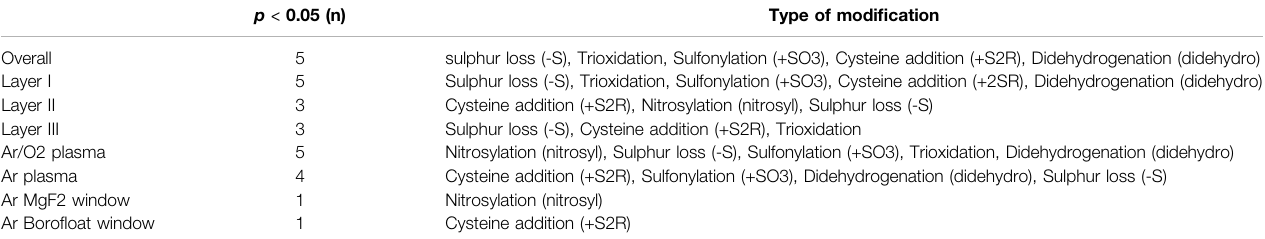
TABLE 3 | Cysteine focused protein modi fi cations observed in porcine epidermis model (ANOVA and Post-hoc analysis Fisher ’ s LSD, p-value and FDR ≤ 0.05). p < 0.05 (n)